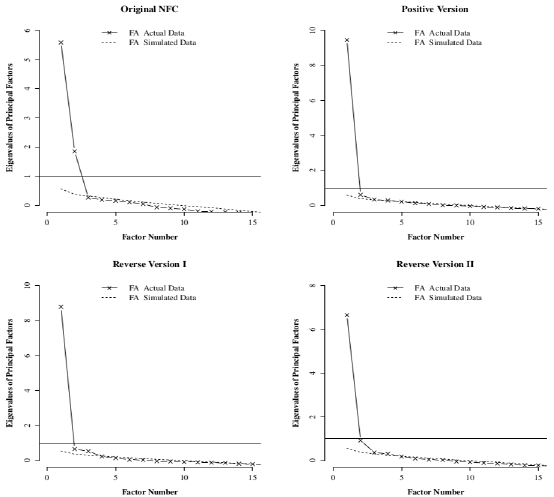
Fig 1. Parallel analyses for the four version of the NFC scale. In each graph, the horizontal line indicates the eigenvalue of one. The straight line is the scree plot obtained from the data. The dashed line is an average scree plot obtained from simulated dataset with the same dimension as the original dataset but generated from a population where all variables are uncorrelated.